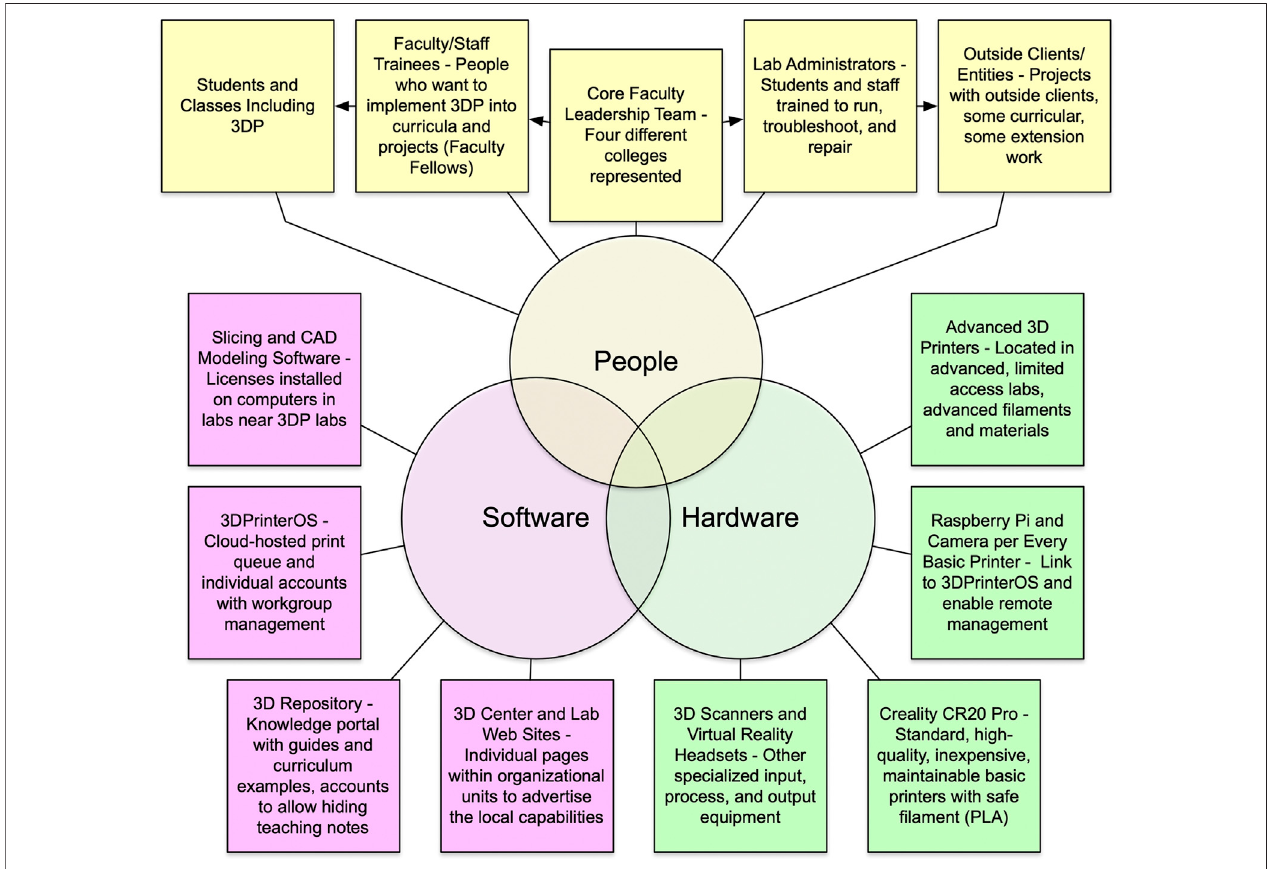
FIGURE 1 | Visualization of the 3D Printing Ecosystem (3DPE) as a coordinated system of hardware, software, and people.